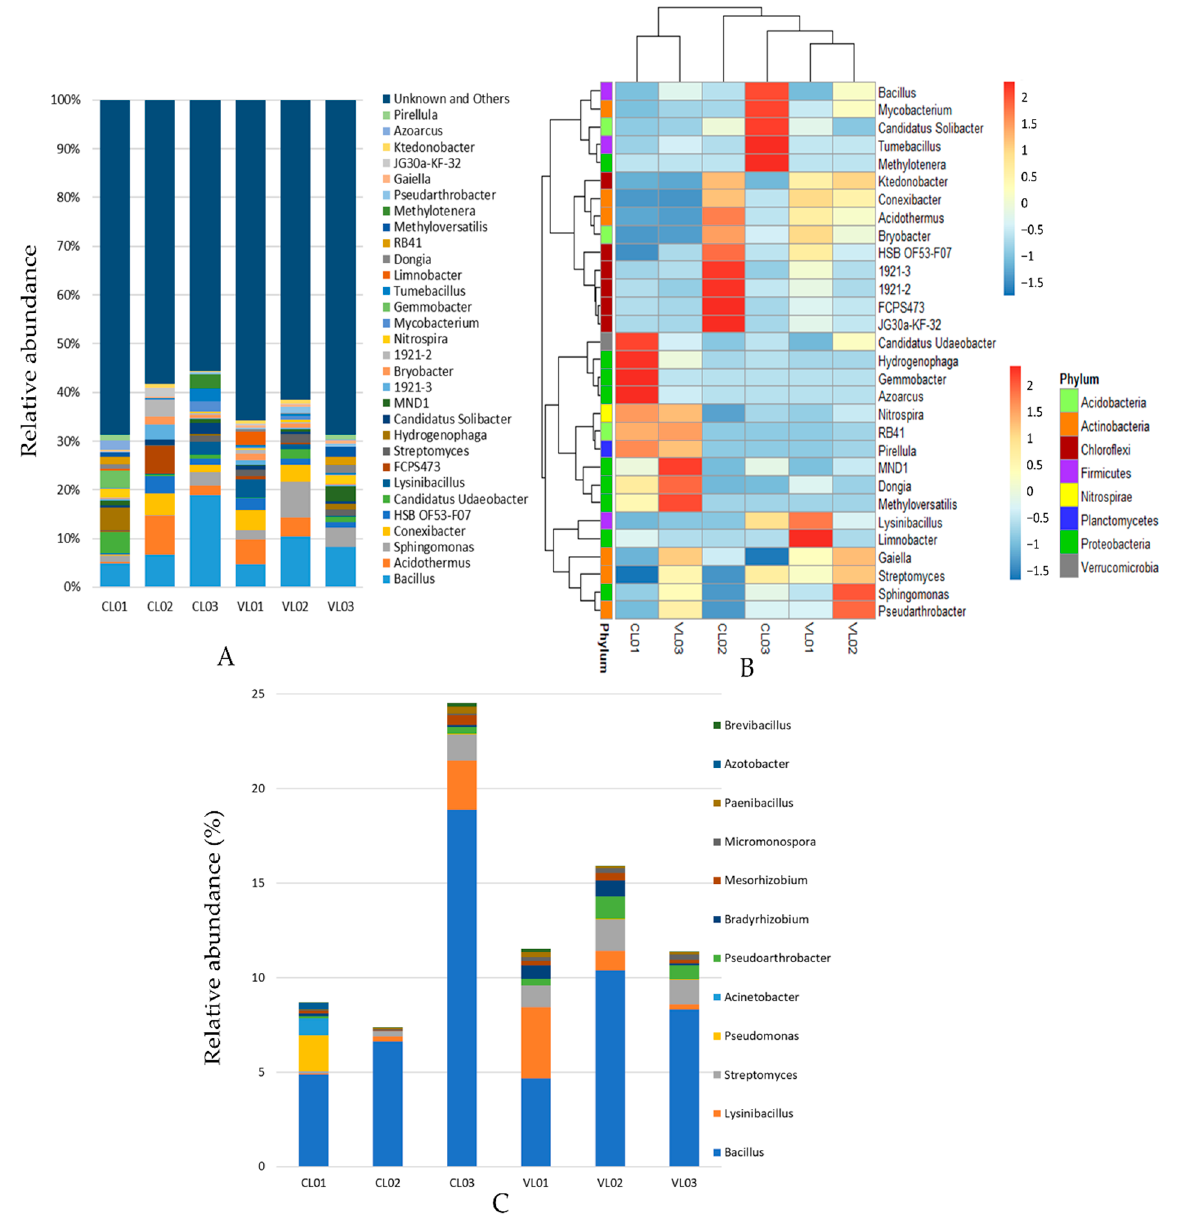
Figure 2. Relative abundance of 16S rRNA gene sequences classified genus level: top 30 genera ( A ) and potential PSB genera ( C ). Potential PSB genera were chosen based on the reports of [7,8]. ( B ) Heatmap illustrating the relative abundance of the 30 most abundant bacterial genera.